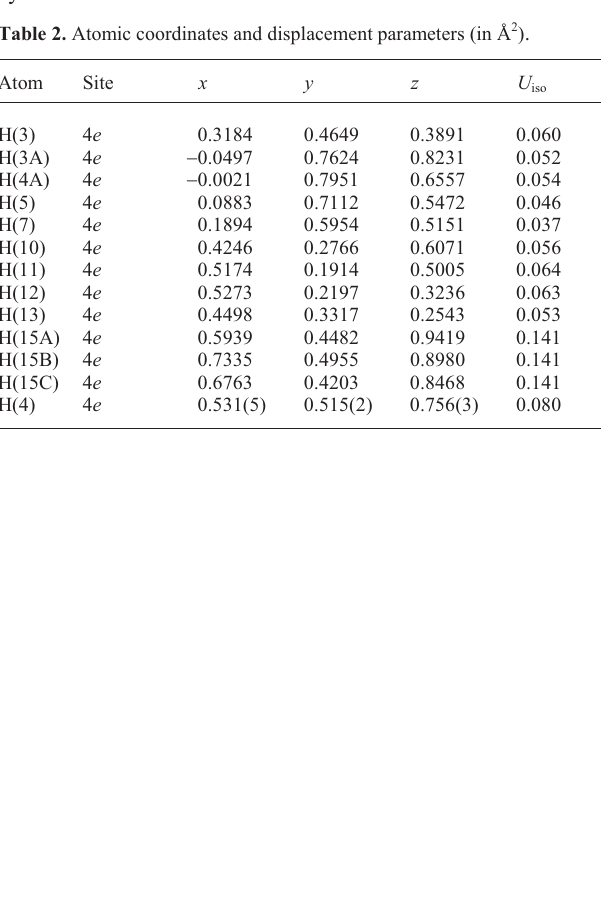
Table 1. Data collection and handling.